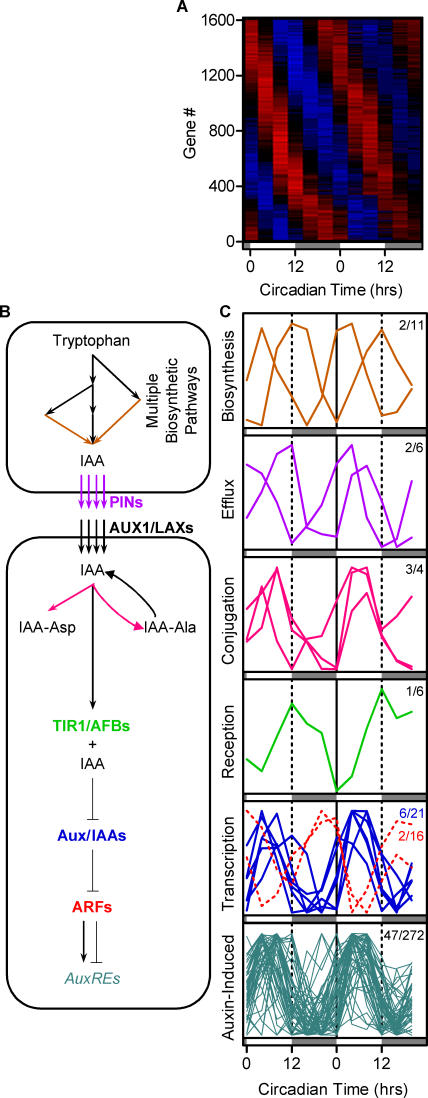
Many Genes in the Auxin-Signaling Pathway Are Circadian Regulated(A) Heatmap representation [74] of 1,610 circadian-regulated genes shows peak expression occurs at all phases. High expression is depicted in red and low expression in blue.(B) Schematic of the auxin-signaling pathway is presented (see Table S3 for the names of genes whose profiles are shown here) [31,34,37,39,42,43]. IAA is synthesized via tryptophan-independent (not shown) and multiple tryptophan-dependent pathways; two enzymes implicated in the final steps of the indole-3-acetaldoxime and indole-3-acetamide biosynthetic pathways are encoded by circadian-regulated genes. IAA, which undergoes polar transport throughout the plant, can be temporarily or permanently inactivated by conjugation to amino acids. Free IAA binds to the TIR1/AFB F-box proteins and facilitates their interaction with Aux/IAA proteins that are subsequently targeted for degradation. Therefore, in the presence of auxin, Aux/IAA proteins no longer prevent the ARF transcription factors from modulating expression of auxin-regulated genes. Steps with clock-regulated gene expression are color coded to match expression data in (C).(C) Normalized microarray expression data for circadian-regulated auxin-signaling [31,34,37,39,42,43] and auxin-induced [36] genes are shown. Genes have been grouped and color coded according to general function or class (see [B]). The fraction of circadian-regulated genes is indicated for each group (see also Tables S2 and S3). A total of 57% of auxin-induced genes show peak expression during a 4-h window in the middle of the subjective day, compared to 22% for all circadian-regulated genes. This ratio increases to 86% for genes highly induced by auxin (≥6-fold).